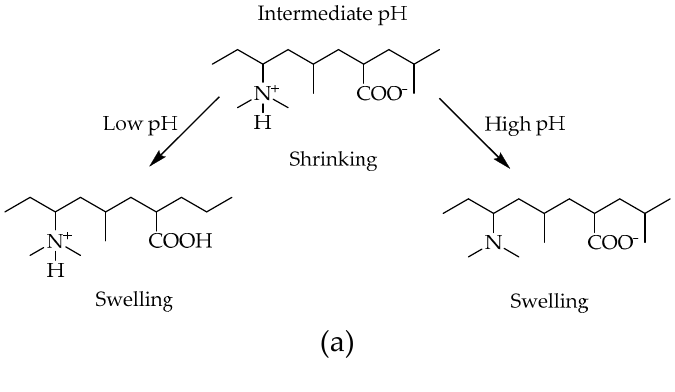
Figure 2. Cont. Figure 2.